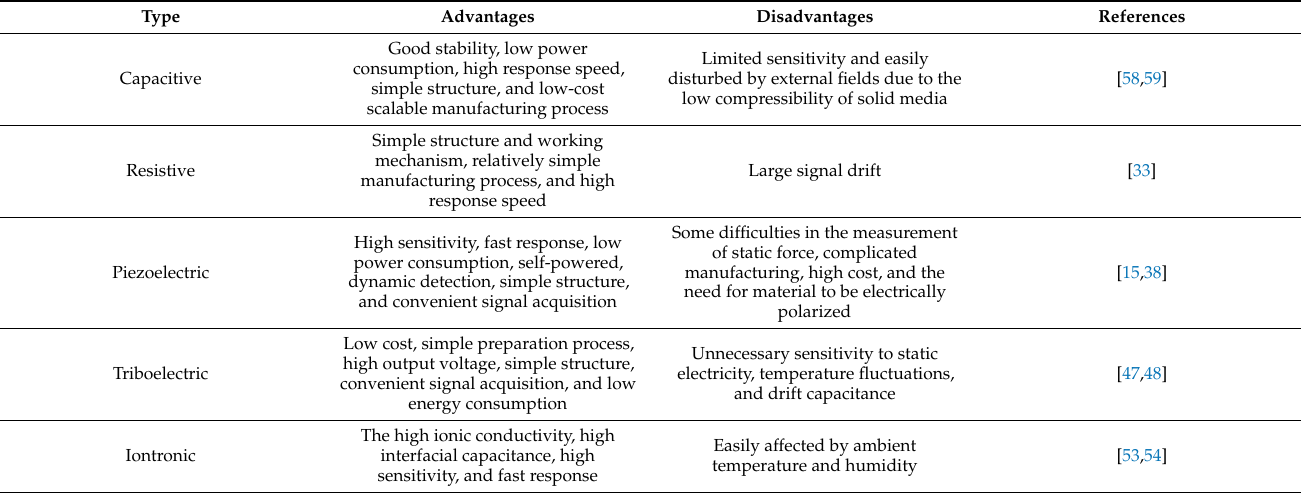
Table 1. Comparison of the advantages and disadvantages of different types of